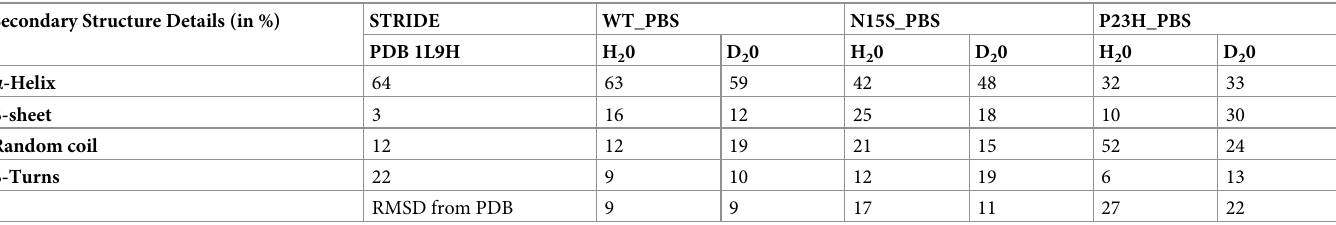
Table 1. Secondary structure composition of WT, N15S and P23H before and after H/D exchange as obtained from FTIR spectra (Fig 4). The root mean squared deviation of both the H 2 O and D 2 O datasets from x-ray data estimates 9% total